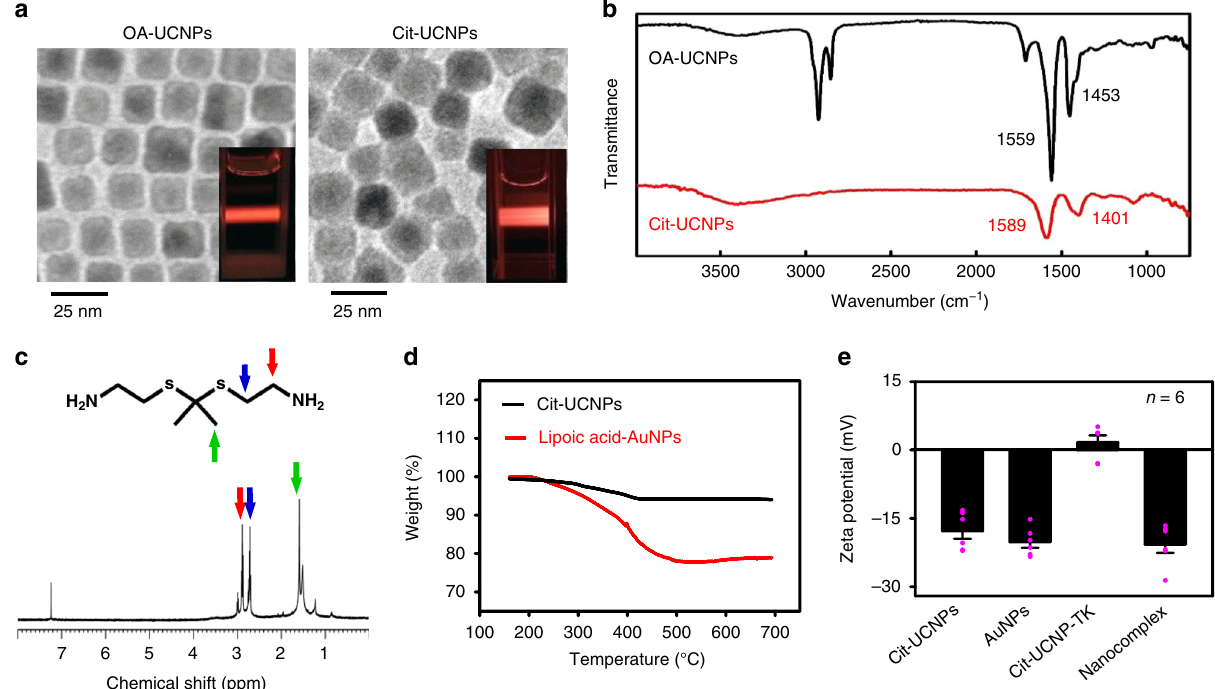
Fig. 3 Characteristics of UCNPs, TK-based linker and nanocomplexes. a TEM images of OA-UCNPs and Cit-UCNPs, and their corresponding emission images under NIR laser irradiation. b FT – IR spectra of OA-UCNPs and Cit-UCNPs. c 1 H NMR spectrum of TK-based linker. d TGA thermograms of Cit-UCNPs and lipoic acid-capped AuNPs. e Zeta potentials of Cit-UCNPs, AuNPs, Cit-UCNP-TK, and nanocomplexes. Data in ( e ) are represented as mean ± SE. Each pink dot represents one observed data point. Source data are provided as Source Data fi